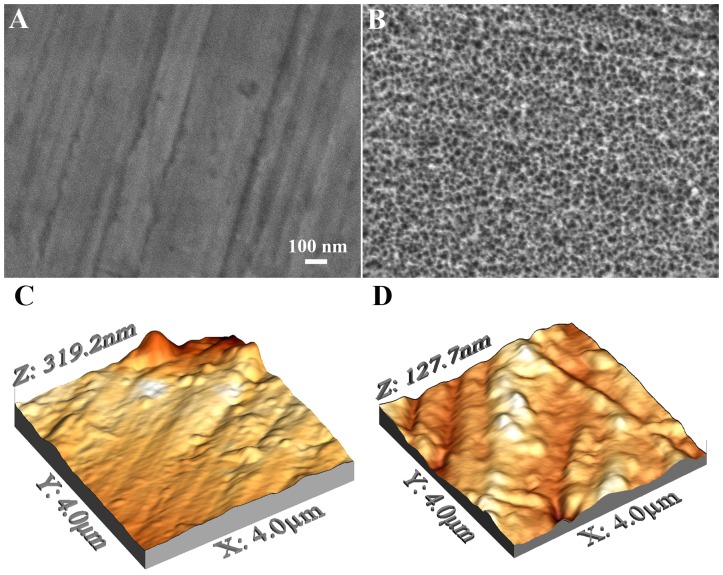
SEM micrograph of controls (A) and nanoporous surfaces (B) generated on titanium by oxidative nanopatterning.While controls are smooth at the nanoscale (micrometric marks due to the mechanical polishing were visible), treated surfaces display the characteristic sponge-like nanostructure. AFM 4×4 μm micrographies of controls (C) and treated (D) titanium.